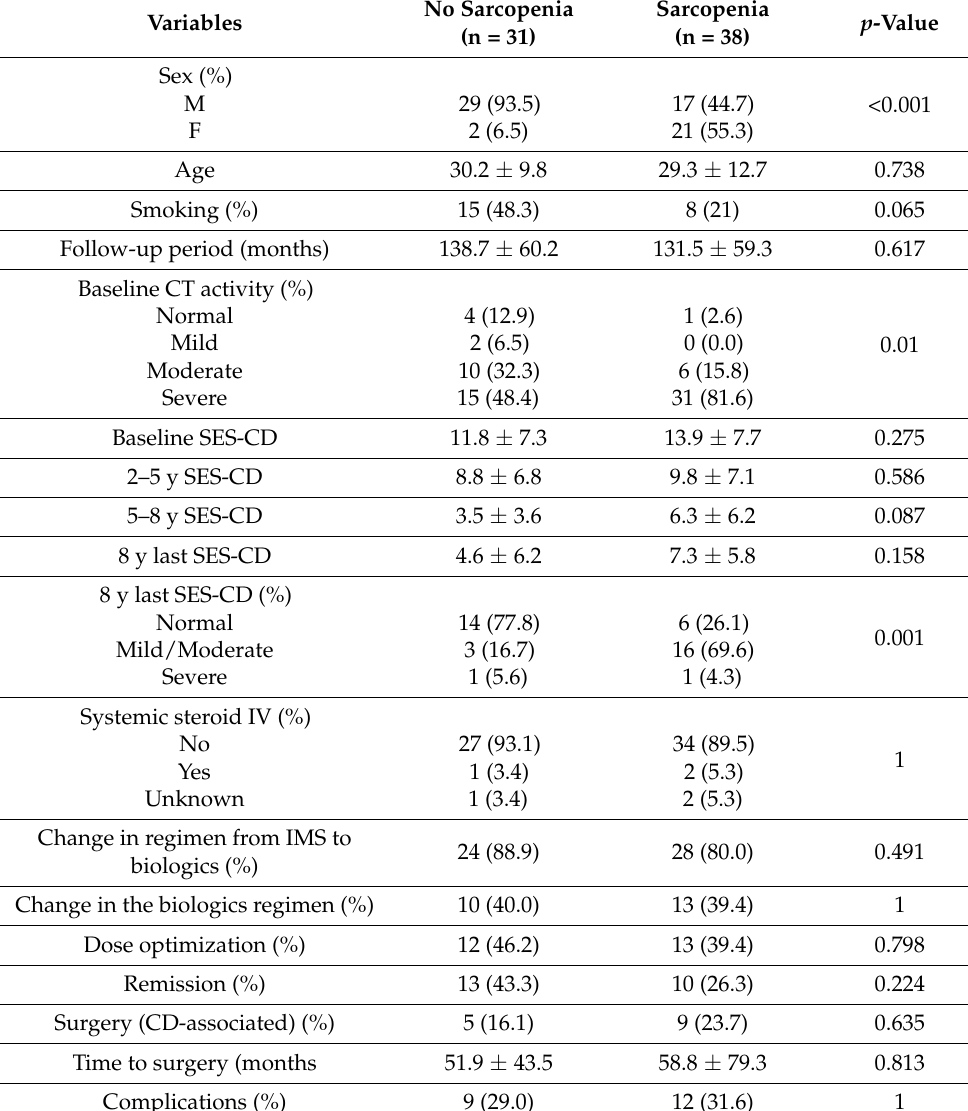
Table 2. Comparison of variables according to baseline